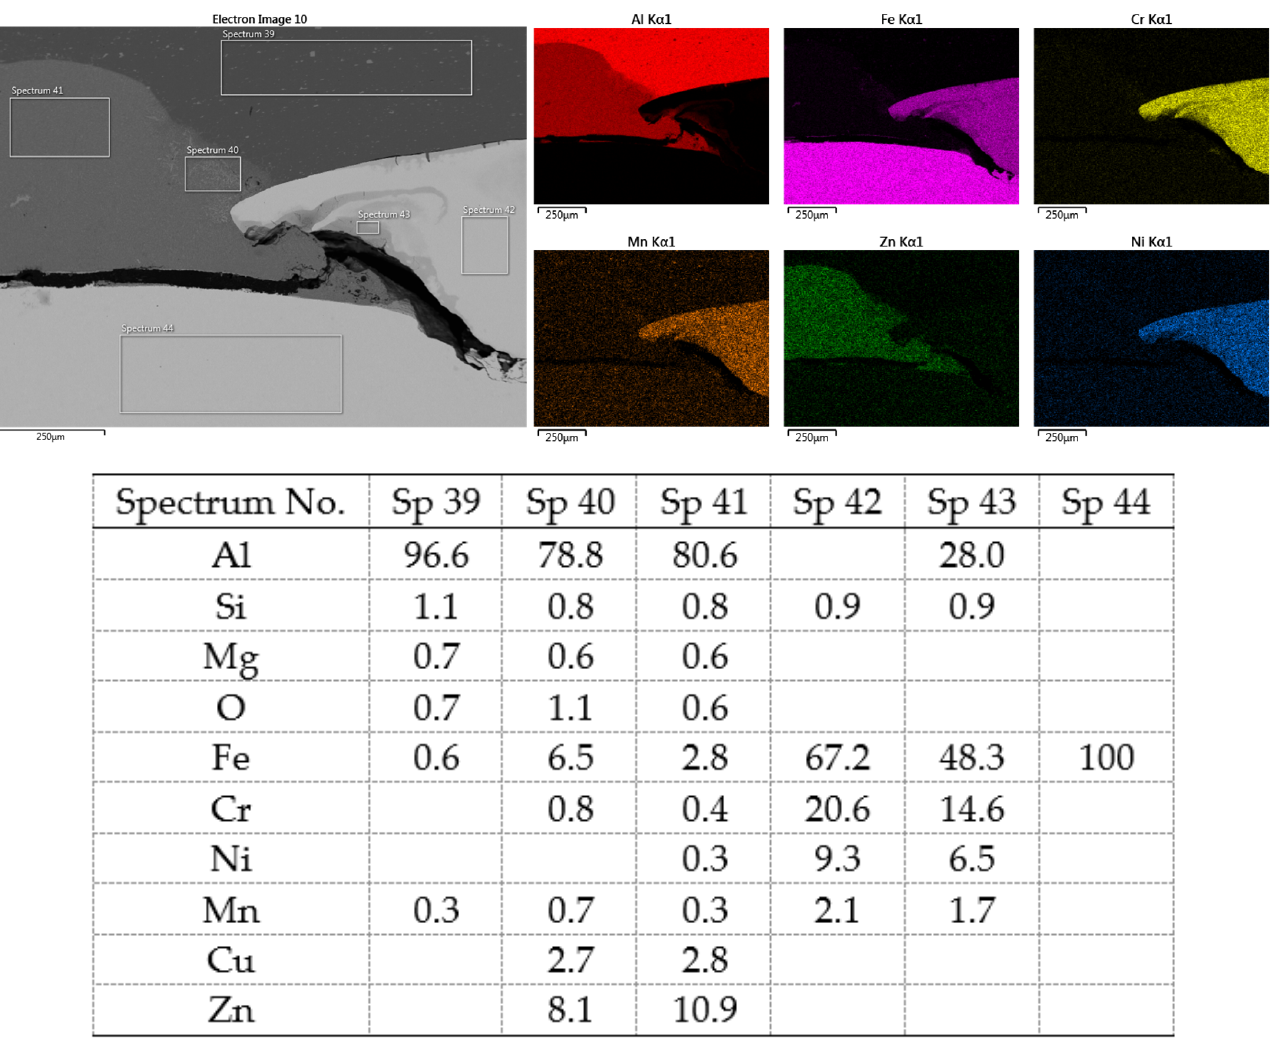
Figure 23. SEM analysis of Al-TL connection, distribution element maps and EDX spectra-detail.